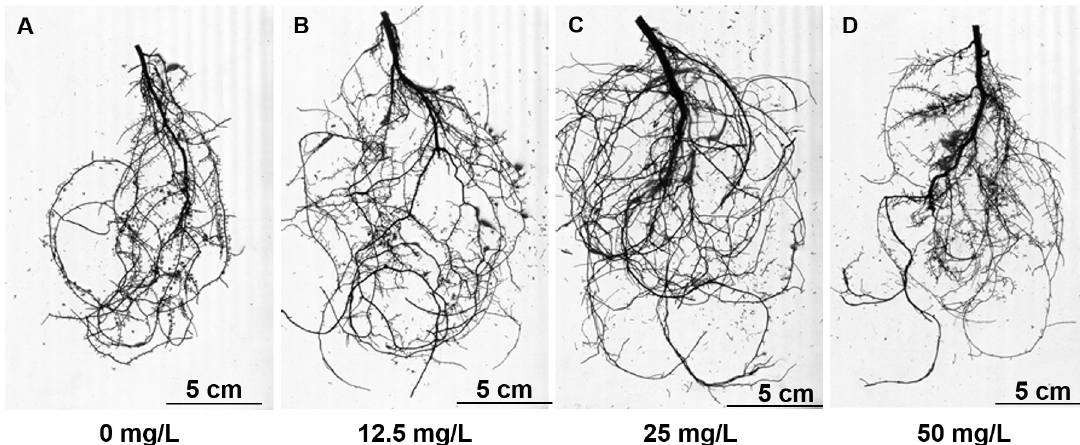
Fig 2. Root morphology of graphene treated